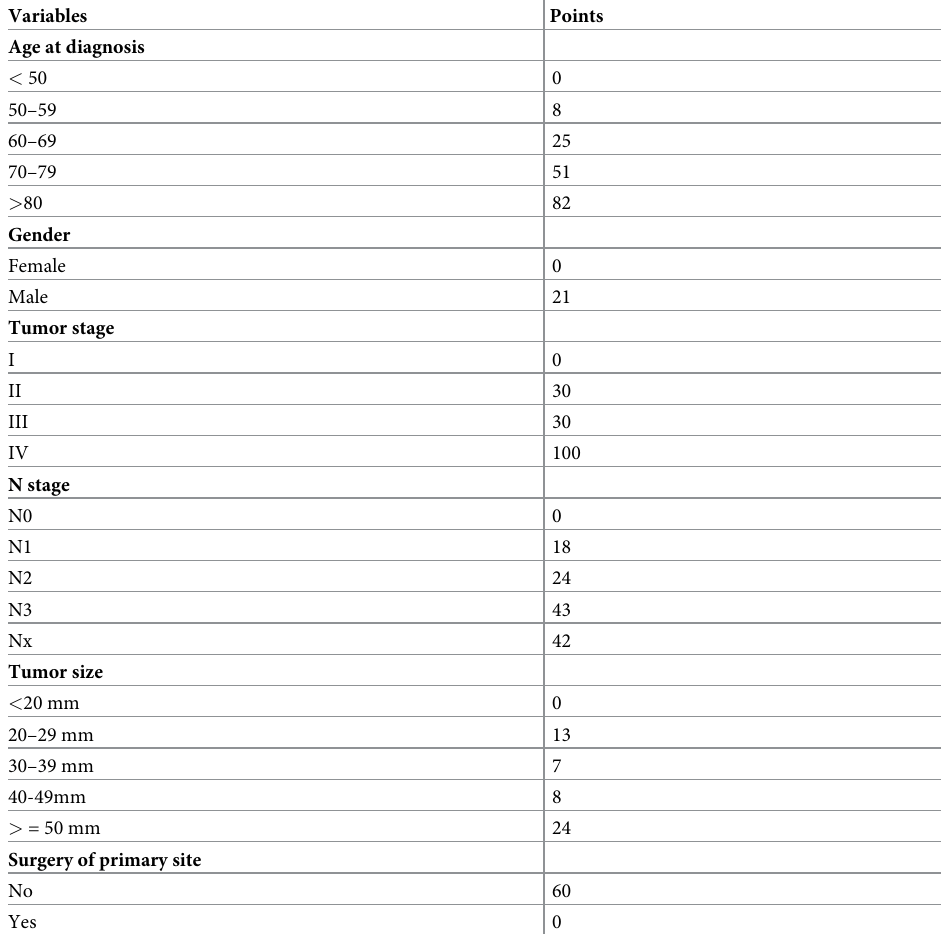
Table 3. Score assignment for each variable included in the